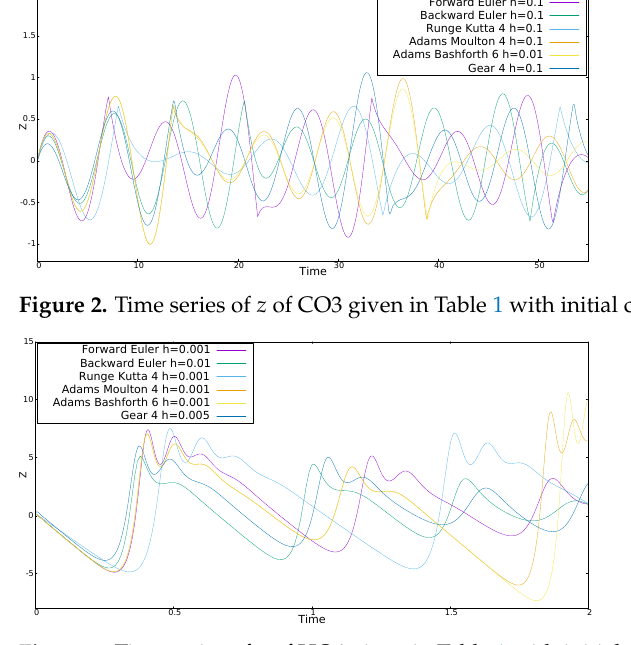
Figure 3. Time series of z of HO4 given in Table 1 with initial conditions x 0 = y 0 = z 0 = w 0 = 0.2.